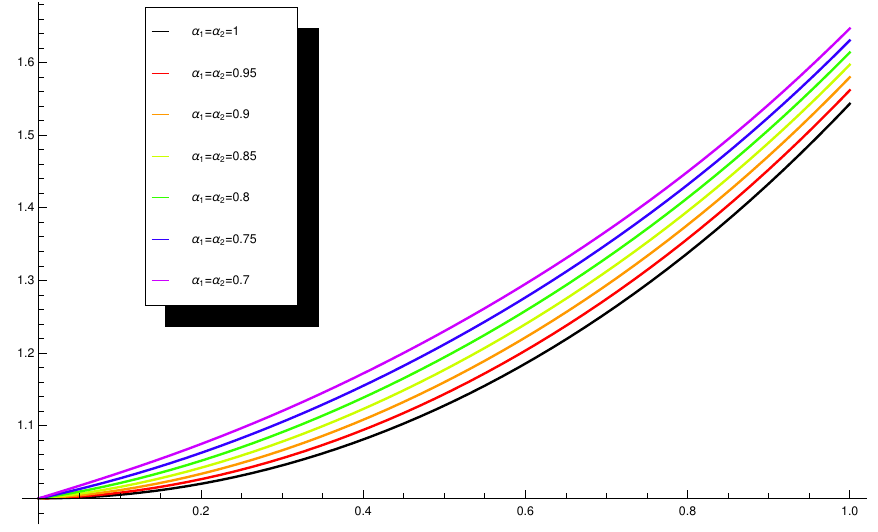
Figure 4. Approximate solutions x 2 of (18) for several values of α 1 and α 2 .